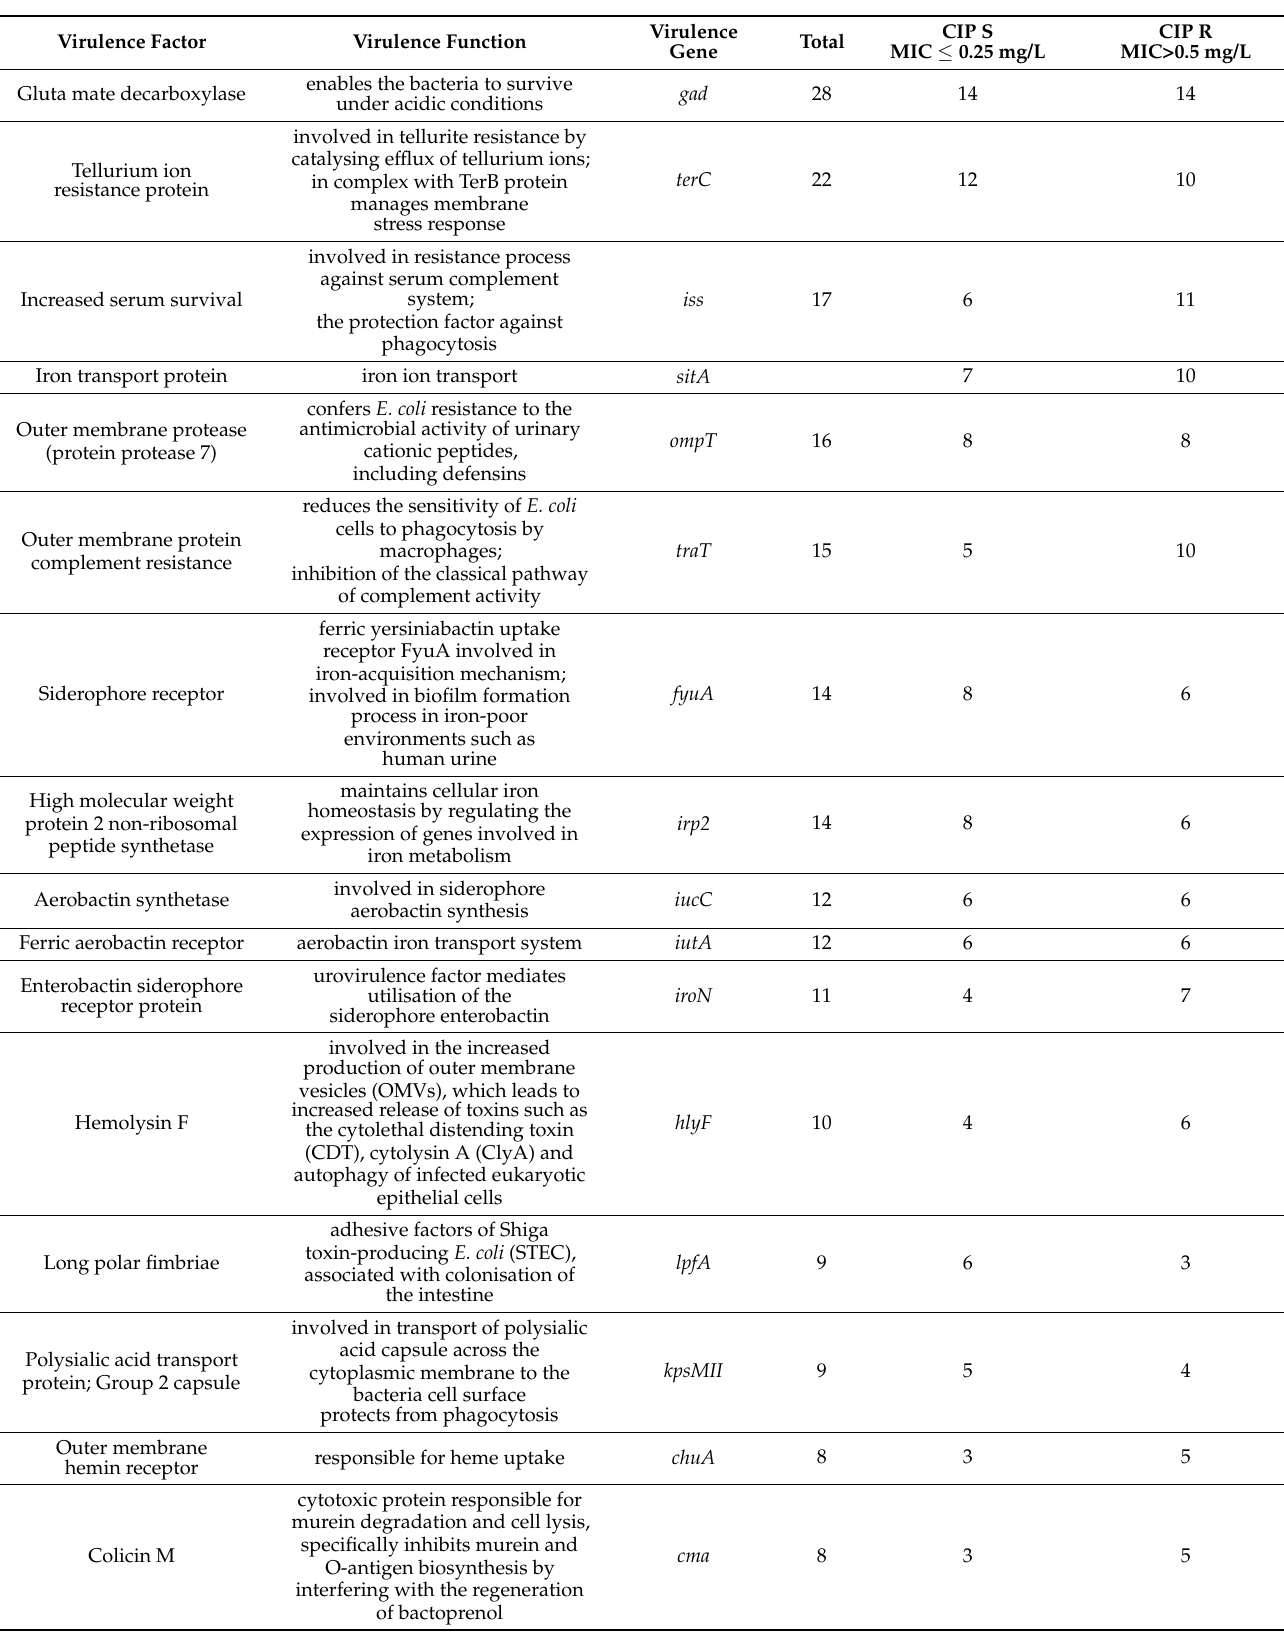
Table 3. Distribution of virulence genes in 28 PMQR-producing E. coli strains isolated from rectal swabs of men undergoing a transrectal prostate